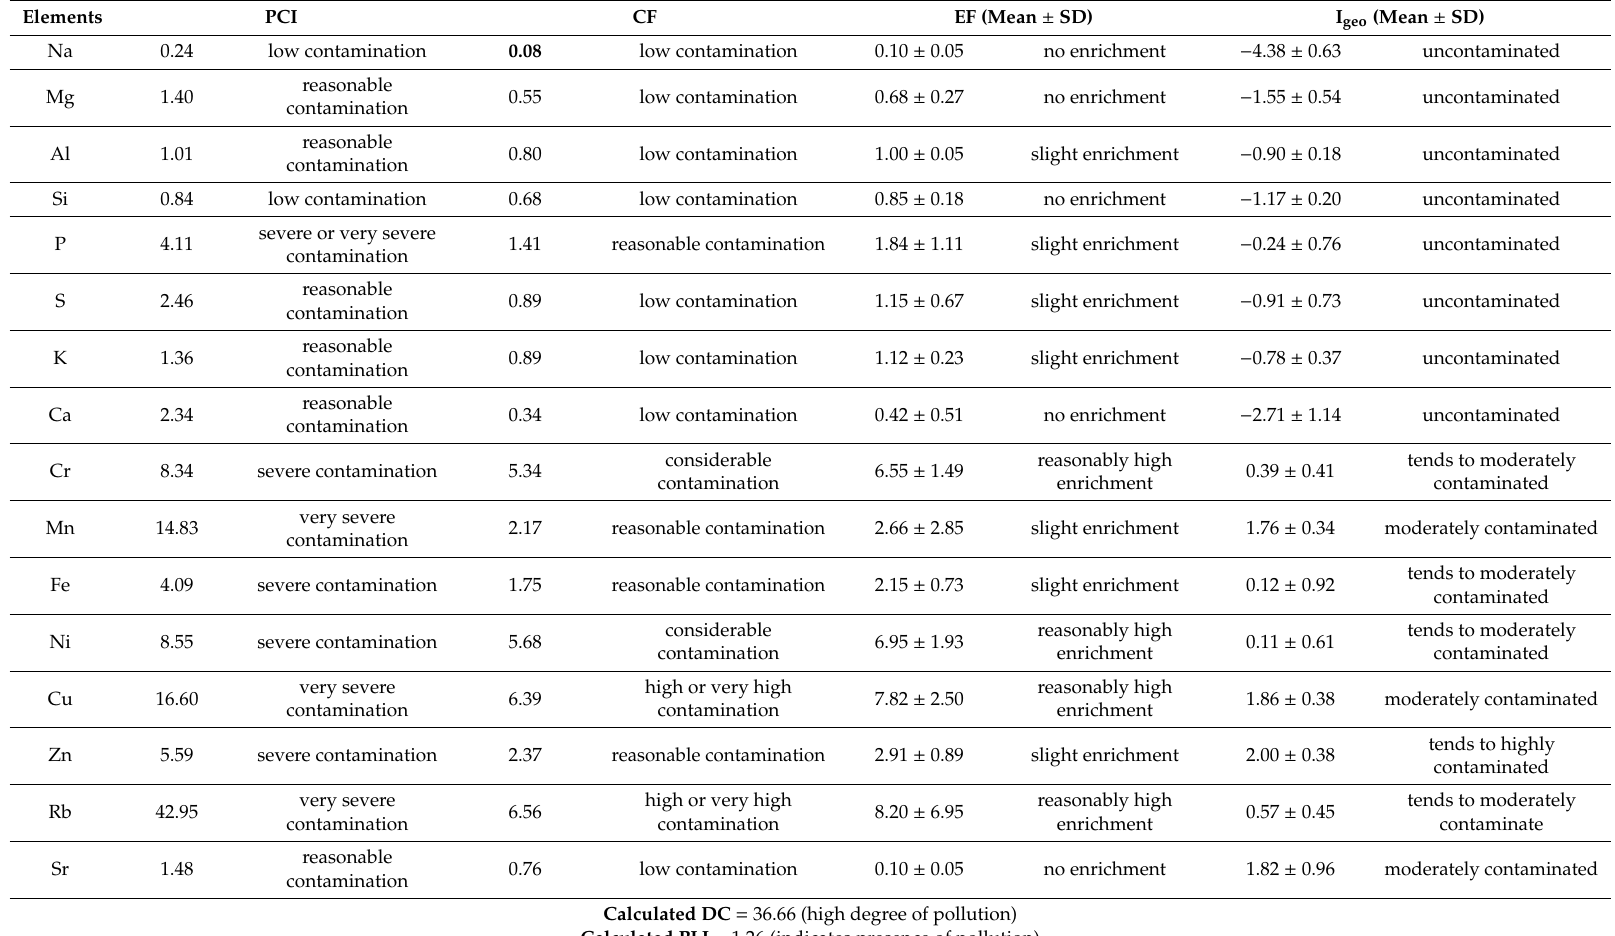
Table 4. Background concentration of individual elements and calculation of eco-environmental